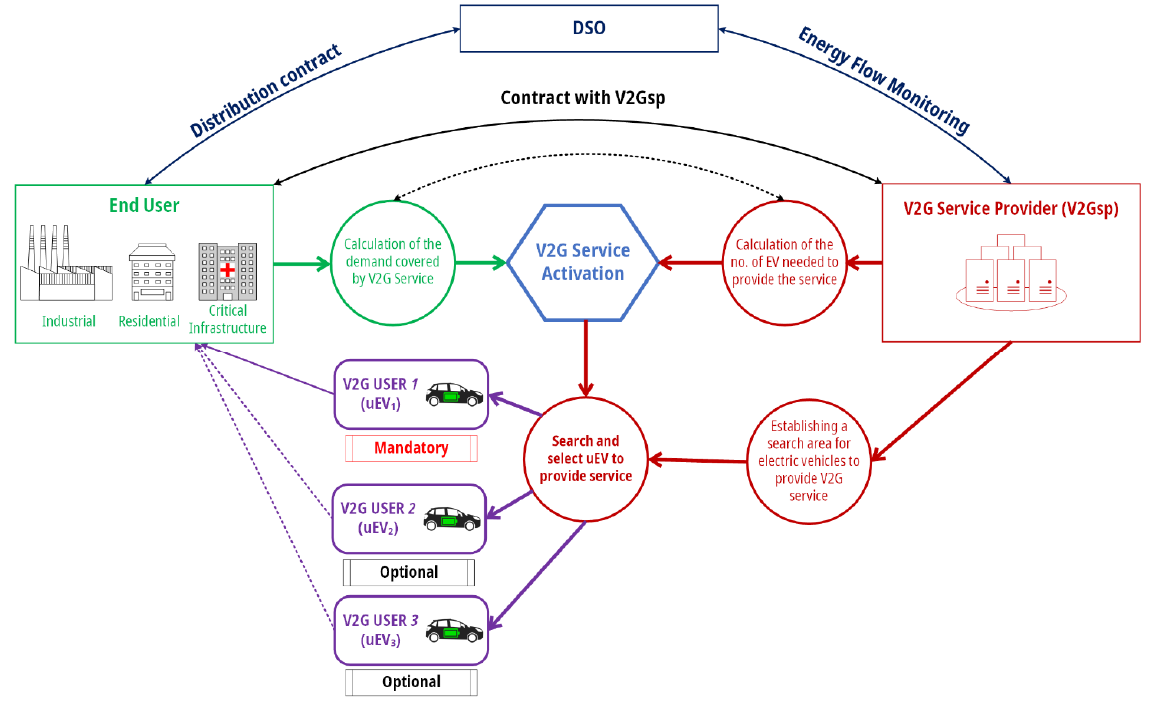
Figure 2. Relations between the actors in the V2G Program—based on [34].